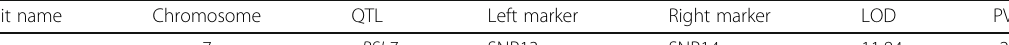
Table 2 Detection information of qRSL7 detected by regional linkage mapping Trait